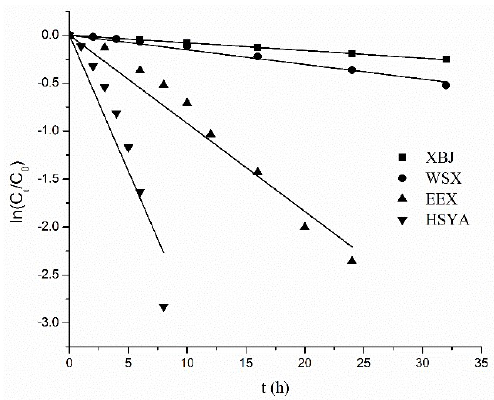
Figure 6. First-order plots for HSYA degradation under specified conditions.